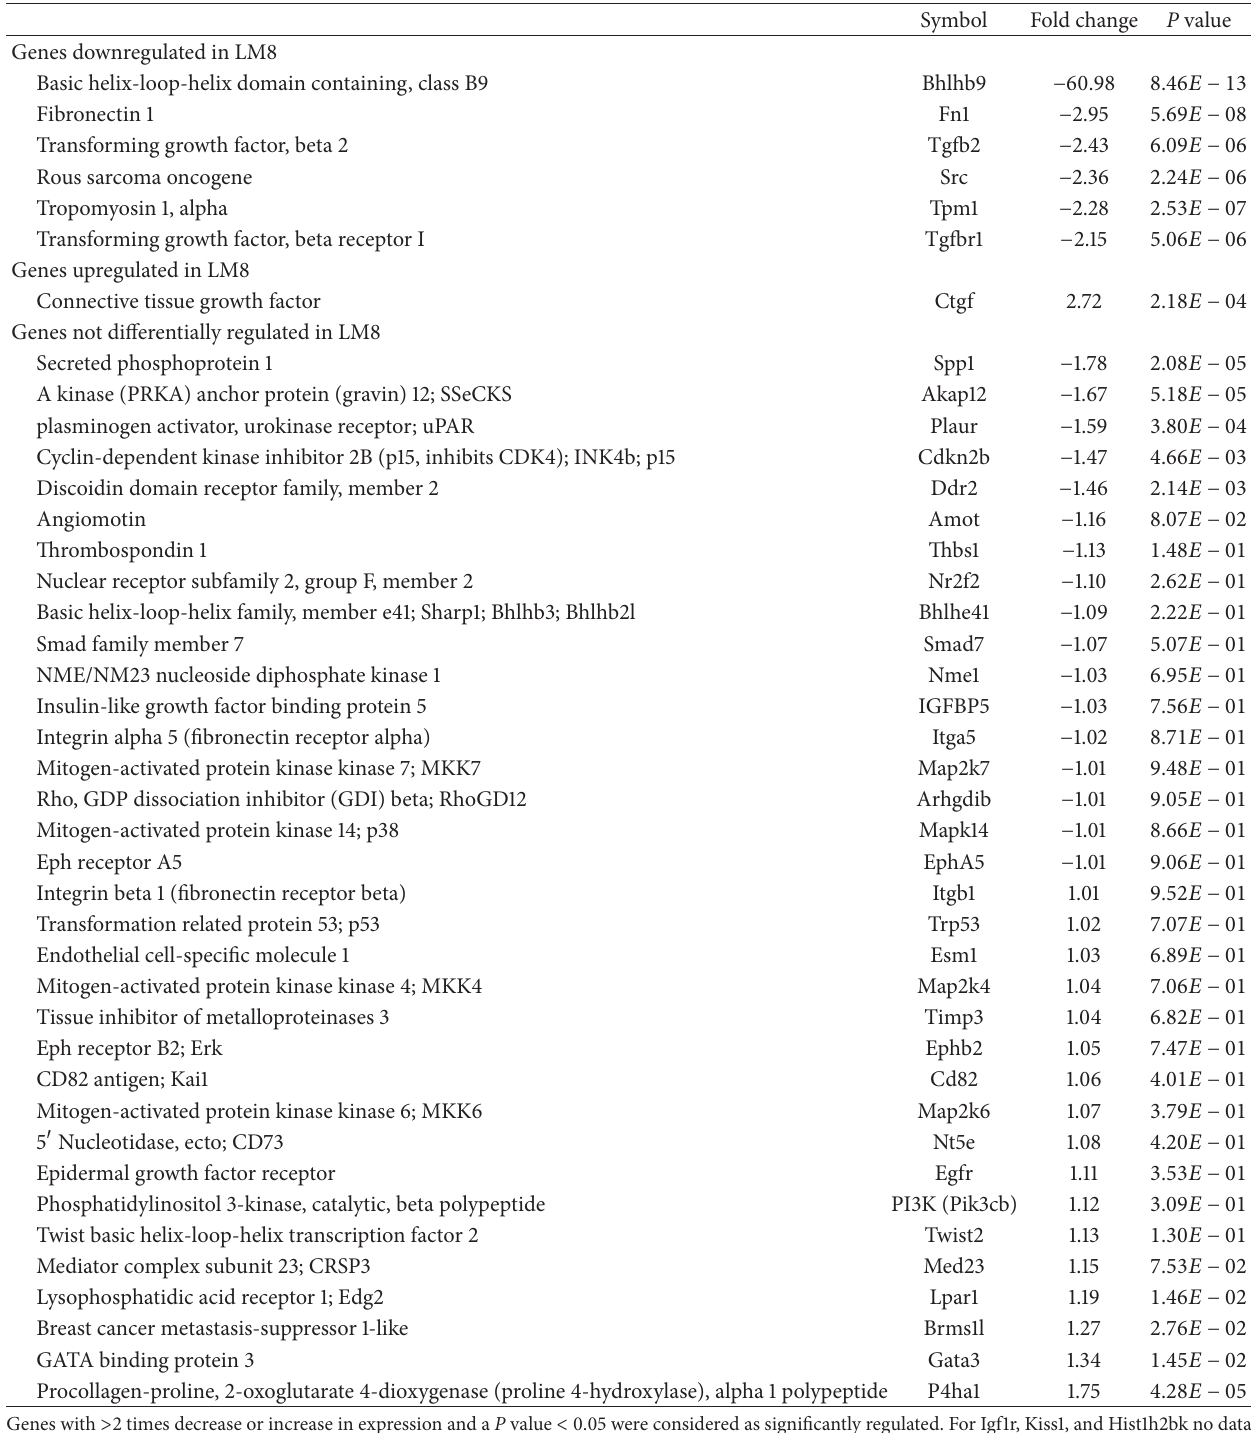
Table 3: Regulation of potential dormancy genes in LM8 compared to Dunn